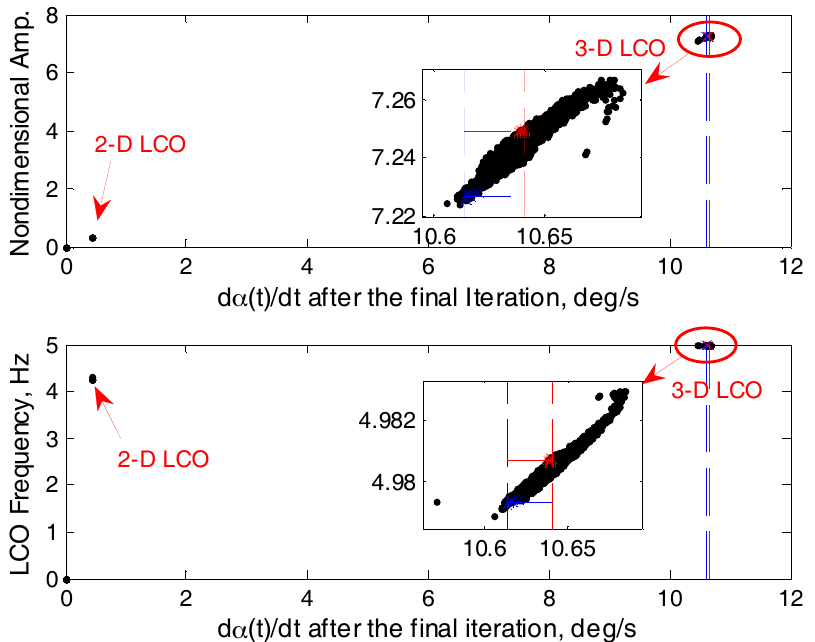
Figure 23. LCO amplitudes and dominant frequencies versus pitch velocity for the fourth iteration. The airspeed is 20 m/s.